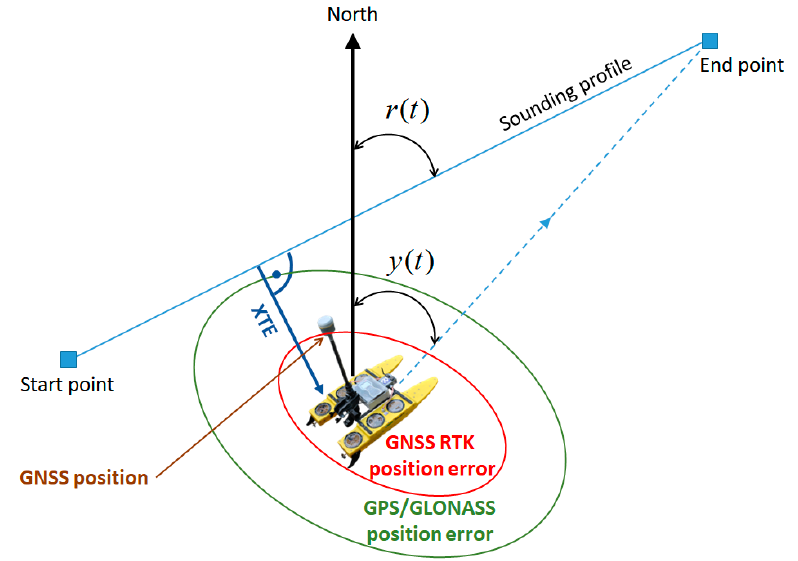
Figure 4. Graphic (navigation) interpretation of the automatic course adjustment system using an autopilot.